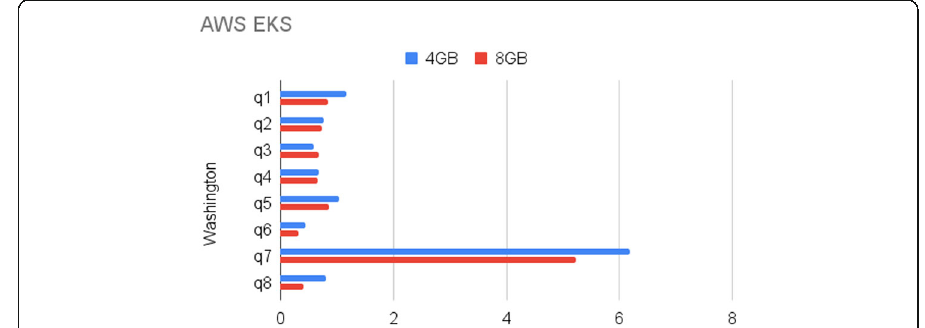
Fig. 14 AET for all benchmarking queries in AWS EKS for Washington